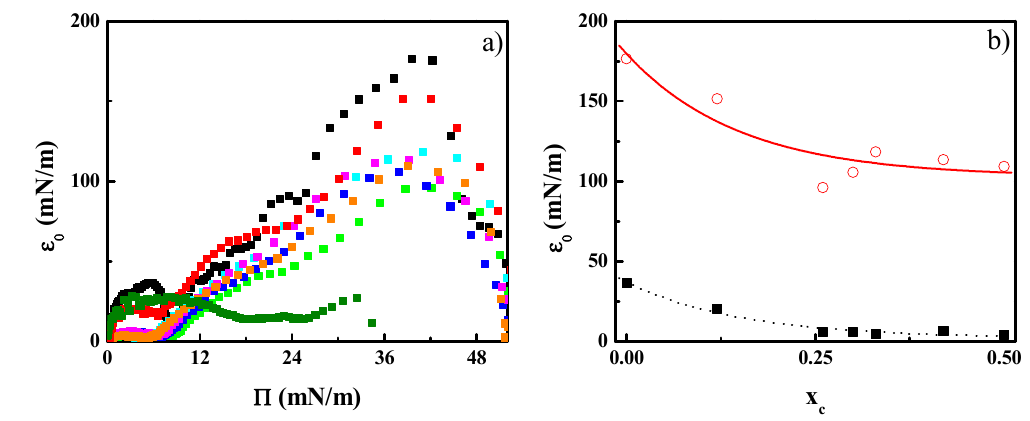
Figure 5. ( a ) Quasi-static dilational elasticity, ε 0 , dependences on the surface pressure, Π , for the Langmuir monolayer of DPPC containing different amounts of CN. Each curve corresponds to DPPC monolayers with a different weight fraction of CN at the interface ( x c ): ( ■ ) 0.00, ( ■ ) 0.12, ( ■ ) 0.26, ( ■ ) 0.30, ( ■ ) 0.33, ( ■ ) 0.42, ( ■ ) 0.50 and ■ 1.00 (CN). ( b ) Dependence of the limit values of the elasticity, ε 0 , on the particle weight fraction, x c , for the liquid expanded phase, LE ( ■ , ∙∙∙∙∙∙ ), and the liquid compressed phase, LC (o, ― ). Notice that lines are guides for the eyes.